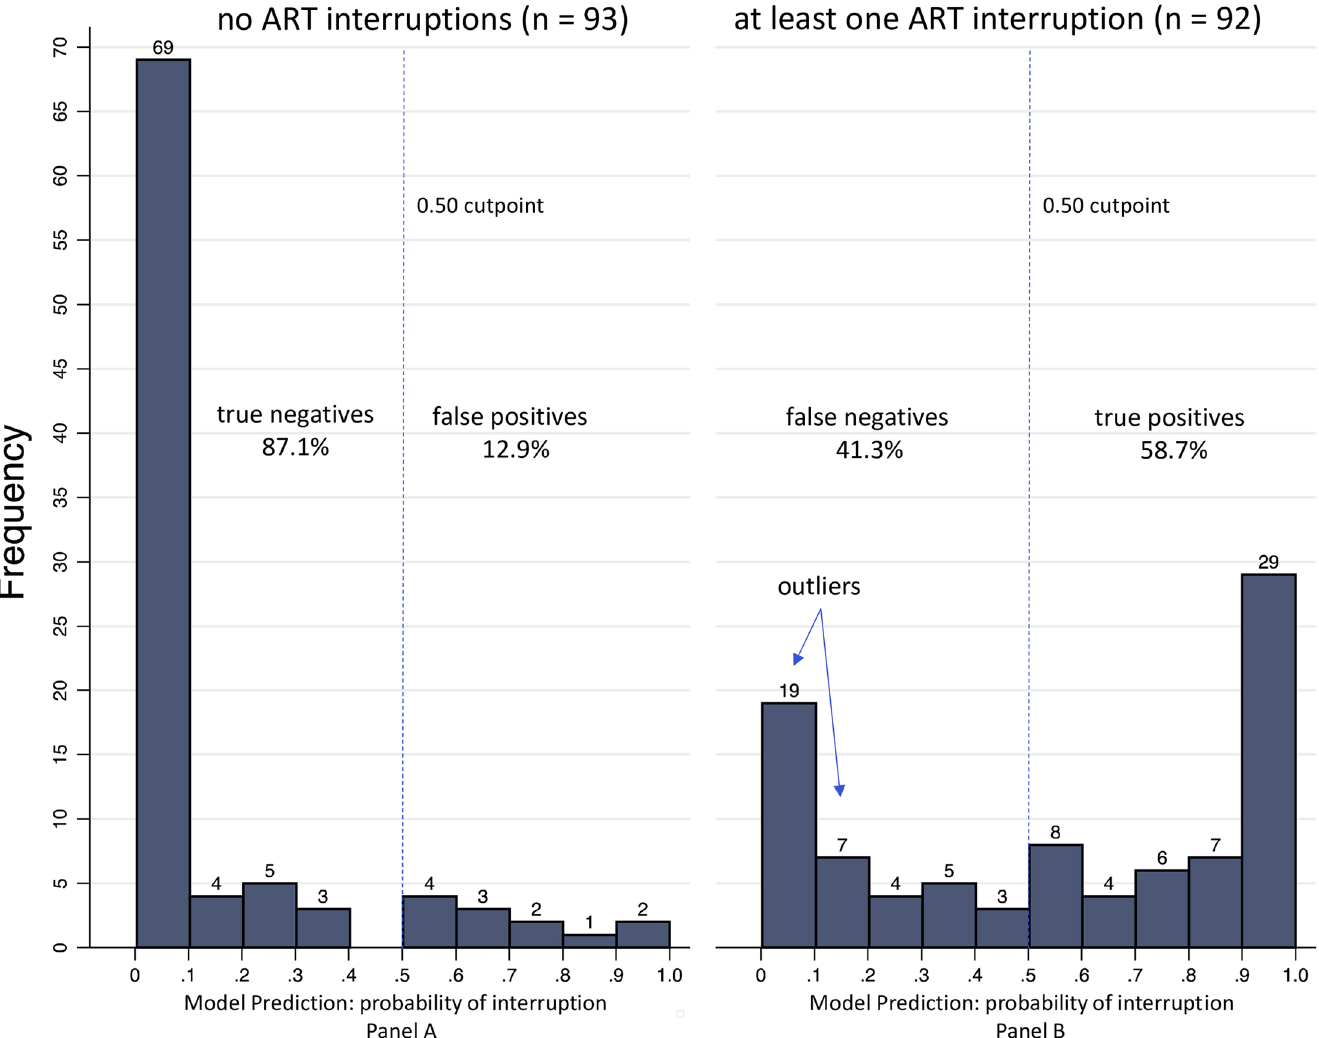
Fig 2. Distribution of model prediction variable by interruption status. Panel A: histogram of the prediction variable for subset of participants who did not have an ART interruption (n = 93). Panel B: histogram of the prediction variable for subset of participants who had at least one (cid:21) 3-day ART interruption (n = 92). Outliers refer to the larger than expected number of participants with a low probability of interruption ( (cid:20) 0.20) who experienced at least one interruption. Pre-determined classification cutpoint for both participant subsets was 0.50. Specificity [true negatives / (true negatives + false positives)] = 87.1%. Sensitivity [true positives / (true positives + false negatives)] = 58.7%. The classification accuracy of the probability model [(true negatives + true positives) / total N] was 73.0%. Outliers were included in the calculations.